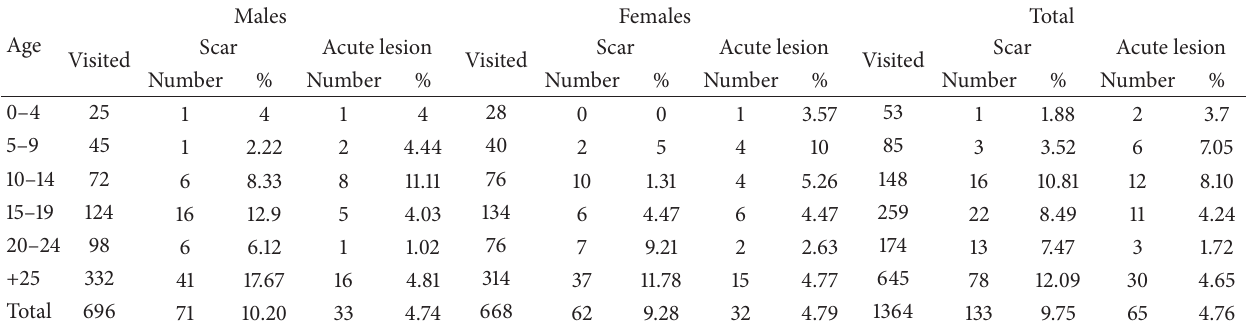
Table 1: Prevalence of acute lesion and scar in the studied families, Khatam County, Yazd Province, central Iran,